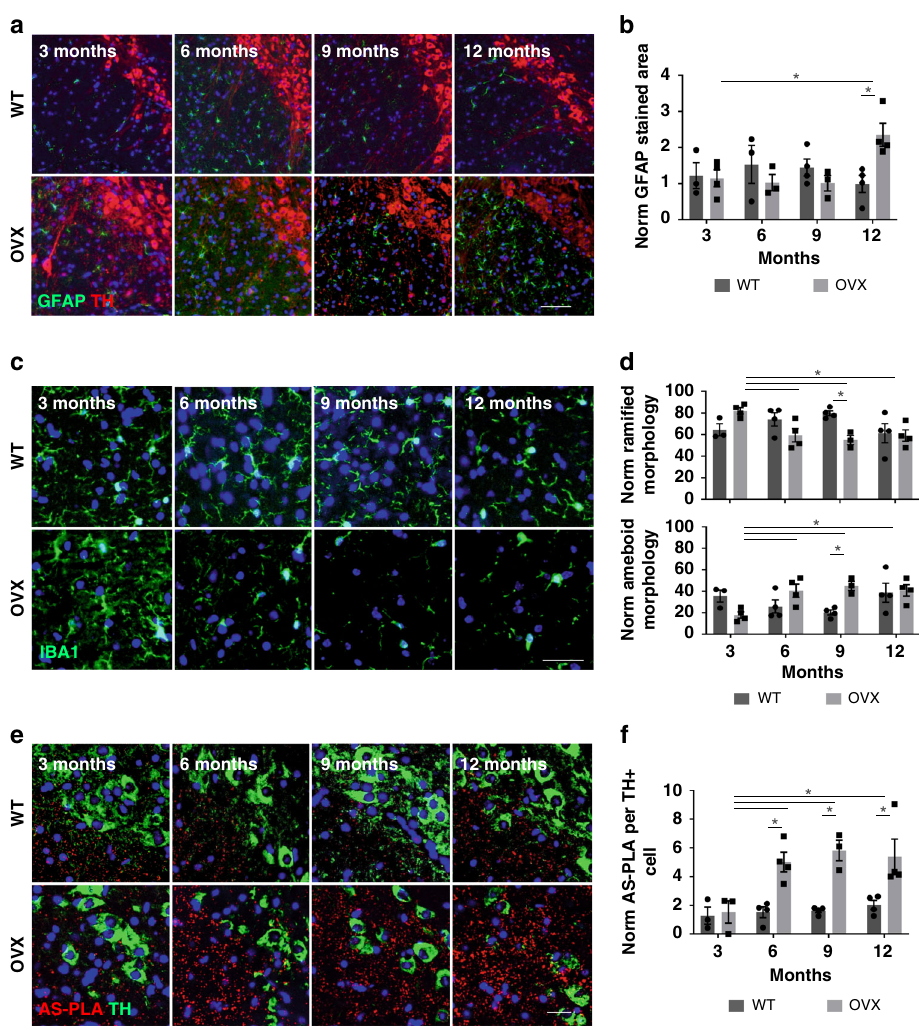
Fig. 3 Glial activation and α -syn aggregation in SNCA-OVX mice. a , c , e Representative images of immuno fl uorescence of GFAP (astrocytes), IBA1 (microglia), and AS-PLA in dopaminergic neurons, respectively. Scale bars = 200, 25, and 25 µ m, respectively. b , d , f Quanti fi cation of normalized stained area, morphology (expressed as a % from total), and puncta per TH + cell analyzed using a two-way ANOVA (Dunnett ’ s for age and Sidak ’ s for genotype, for age all values compared to 3 months), n = 3 – 4 animals per group. b F(3, 20) = 1.211, p = 0.0177 for age and F(1, 20) = 0.1572, p = 0.0106 for genotype. d F(1, 22) = 2.216, p = 0.0287 for genotype and F(3, 22) = 1.764, p = 0.0209, p = 0.0104, p = 0.0192 for age. f F(3, 21) = 4.528 for age, p = 0.0058, p = 0.0016, p = 0.0024 and F(1, 21) = 33.41, p = 0.0043, p = 0.0015, p = 0.0061 for genotype. * p < 0.05. For all appropriate panels, data are presented as mean values ± SEM. OVX: SNCA